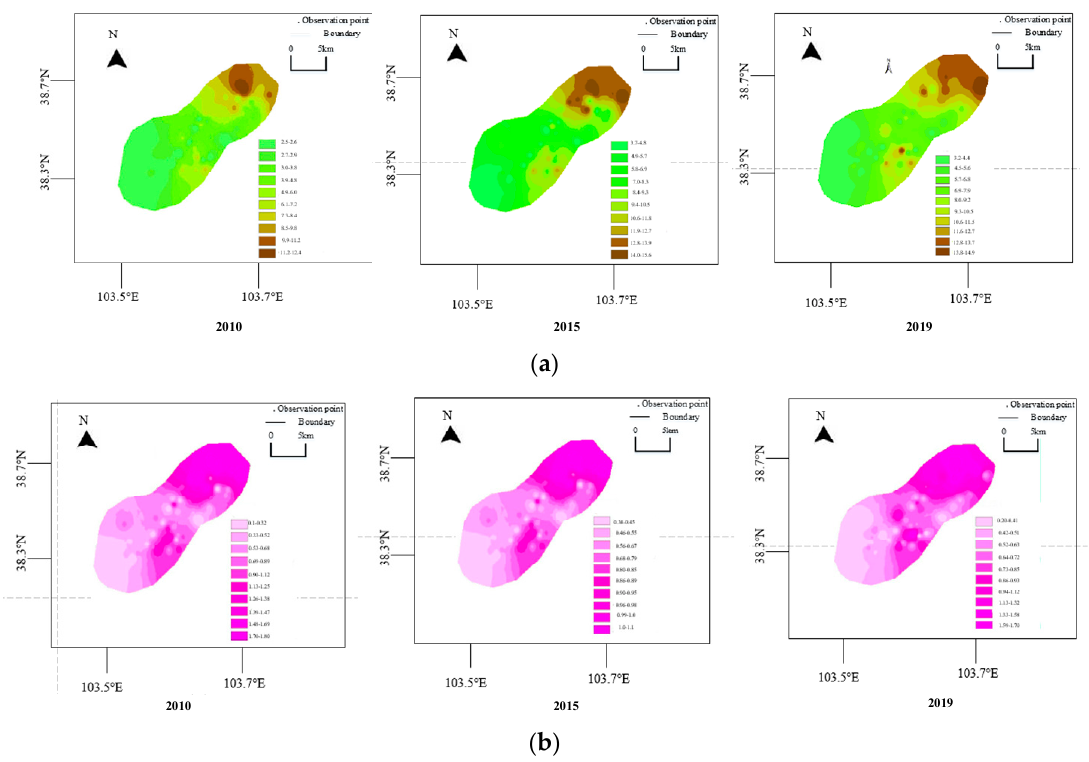
Figure 4. Fitting results of the spatial distribution of the research area: ( a ) shows the results based on permanganate, and ( b ) shows the results based on ammonia nitrogen.